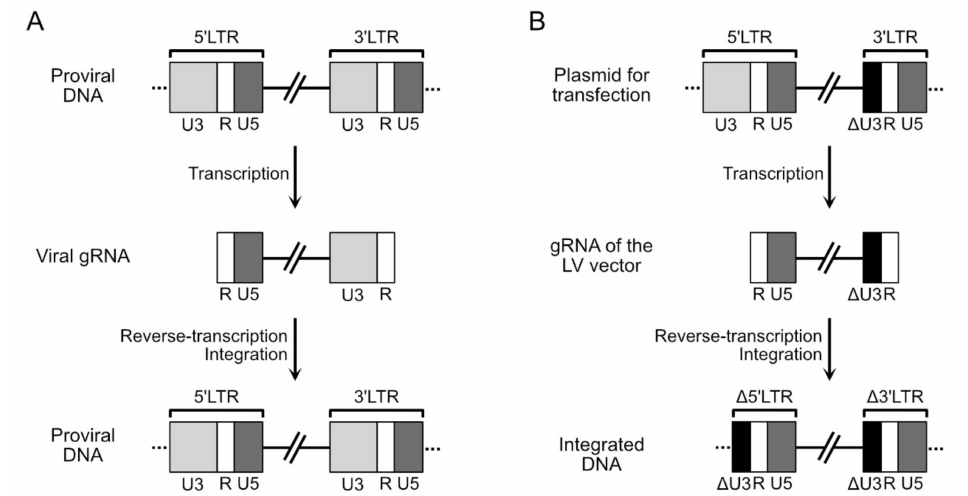
Figure 2. Schematic representation of the structure of the genomic forms of the viral DNA during natural infection (panel ( A )) or during transfection and transduction by a self-inactivating (SIN) lentiviral-derived (LV) vector (panel ( B )).